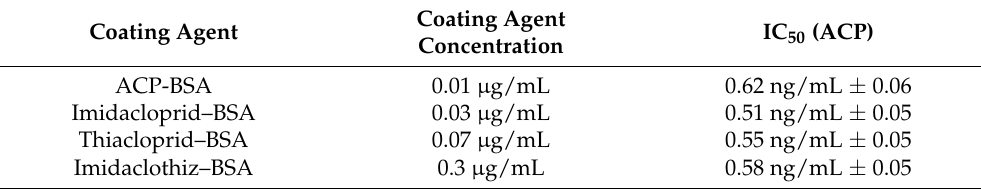
Table 2. ELISA results for specificity of anti-ACP mAb with each of the four coating agents.